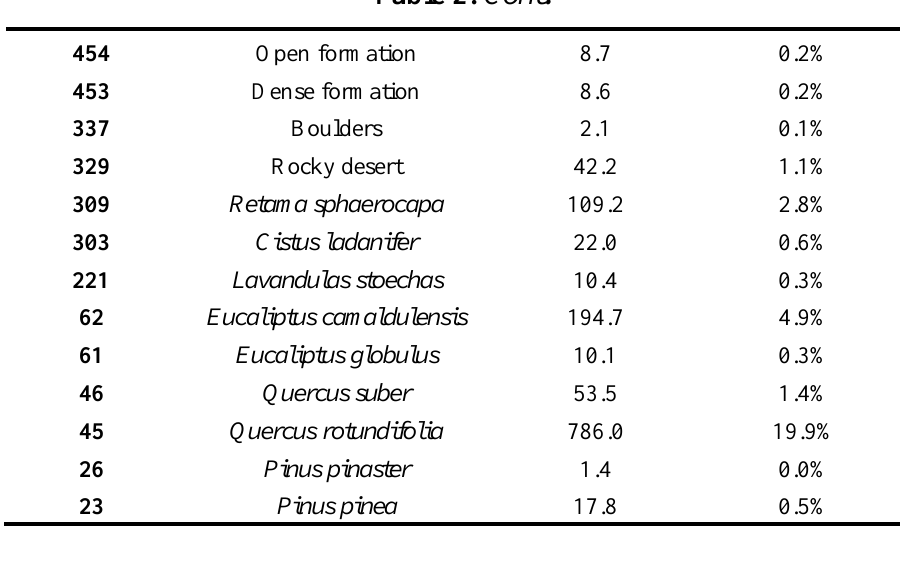
Figure 2. Extremadura forest map